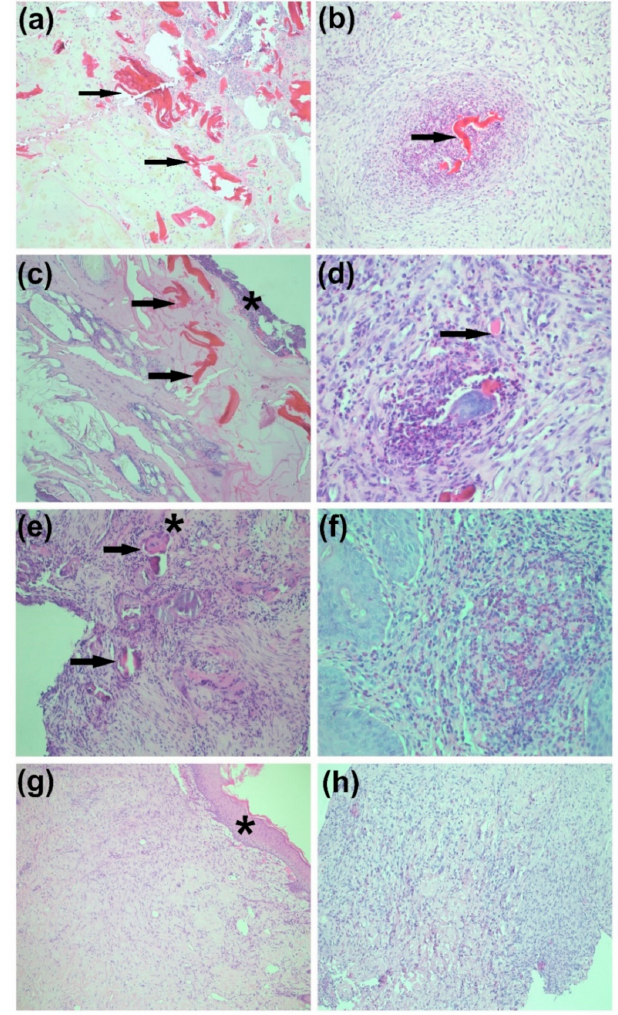
Figure 15. Histological overview of a hematoxylin-eosin-stained section of rabbit skin after implanta- tion of Coll/Chit without FGF2 after 7 days ( a ); 14 days ( c ) and 21 days ( e ); and after implantation of pure dermo–epidermal graft after 21 days ( h ). ( a ) Some Coll/Chit biomaterial residue with mixed inflammatory cell infiltrate in the deeper tissue layers. No significant evidence of resorptive reaction. ( c ) Evidence of Coll/Chit scaffold residues with mixed inflammatory infiltration in the environment. Epithelial layer is present on the surface. ( e ) Presence of Coll/Chit biomaterial residue at the defect site, with mixed inflammatory cell infiltrate and granulation tissue. Numerous multinucleated foreign body giant cells are visible ∗ . ( h ) Newly formed tissue at the site of a previous defect without significant inflammatory infiltration. Magnification is 100 × for all images. Histological overview of a hematoxylin-eosin-stained section of rabbit skin after implantation of Coll/Chit_0.1FGF2 followed by time intervals of 7 days ( b ), 14 days ( d ), and 21 days ( f , g ). ( b ) Coll/Chit scaffold residues with mixed inflammatory infiltration in the environment, magnification 100 × . ( d ) The Coll/Chit biomaterial residue with mixed inflammatory infiltration in the area and with the formation of granulation tissue and one type of huge multinucleated cell of foreign bodies (modified macrophages—these cells are commonly found at the site of biomaterials and indicate of granulation tissue formation), which is a sign of very good chitosan resorption ability, magnification 100 × . ( f ) Implant site after complete chitosan resorption with mixed inflammatory infiltration and formation of granulation tissue in the area, magnification is 100 × . ( g ) Newly formed tissue at the site of a previous defect without significant inflammation and infiltration, superficial epithelial layer ∗ , magnification is 200 ×